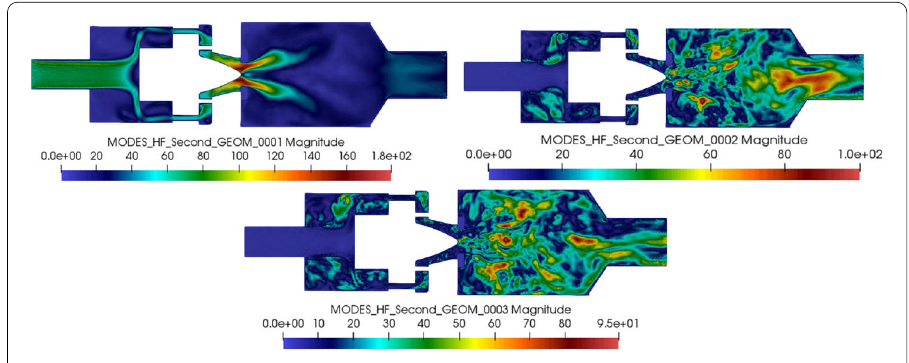
Fig. 37 Velocity modes with respect to the HF solution in the complete fluid domain associated with the second configuration